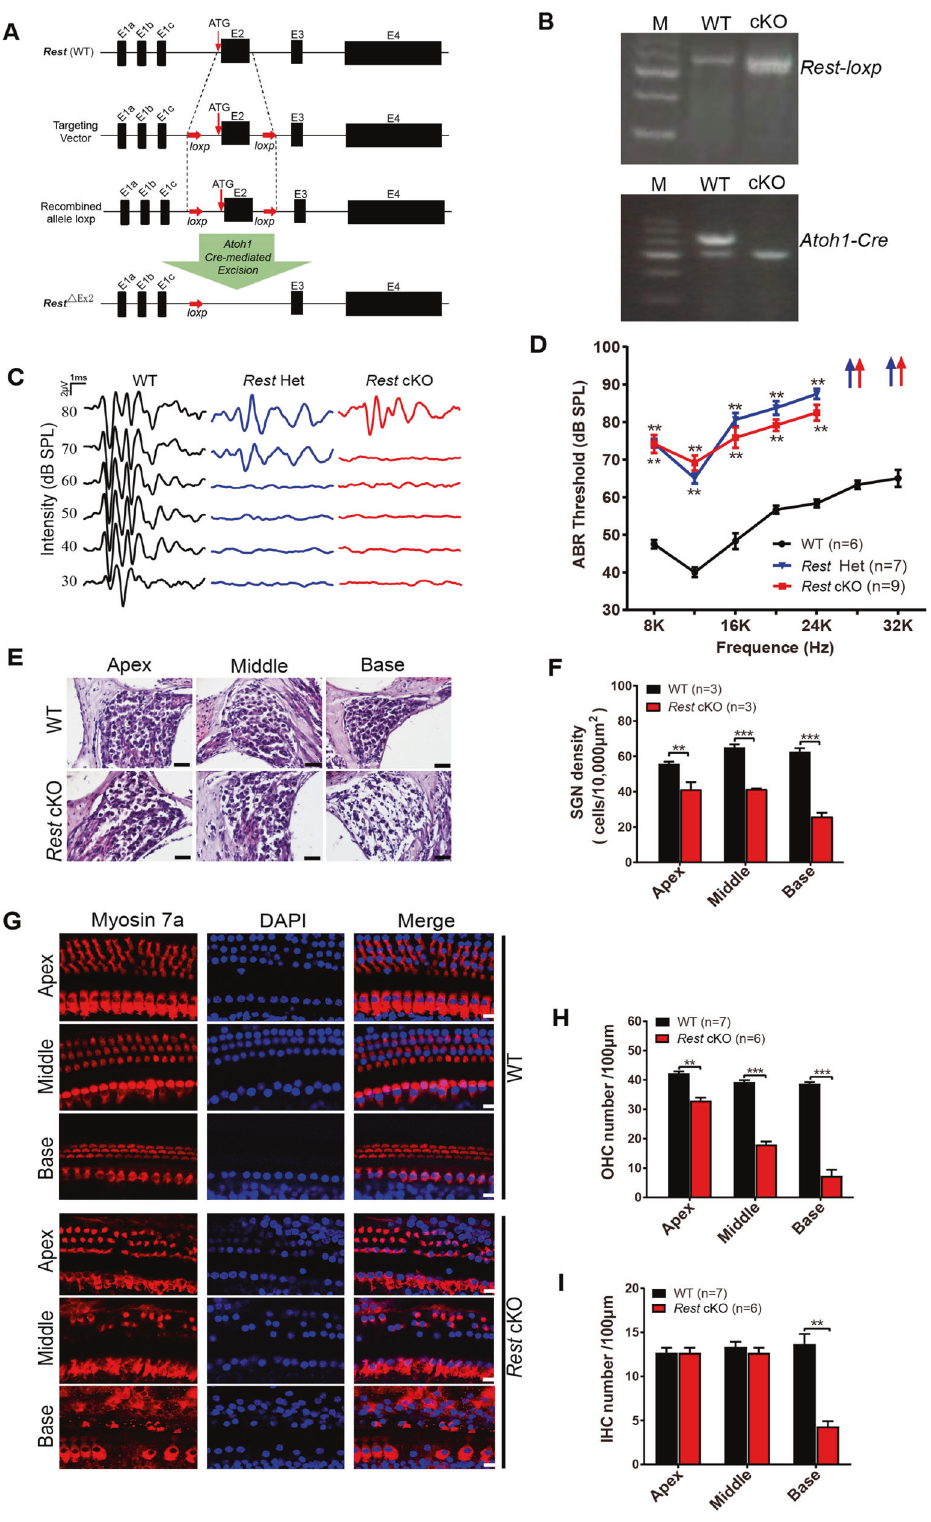
Fig. 3 Deletion of REST in cochlear results in hearing impairment in mice. A Schematic illustration of the Rest conditional knockout ( Rest cKO) generation process. Two LoxP sites are inserted on either side of the coding sequence of exon 2. Expression of Cre recombinase is activated by a speci fi c Atoh1 promoter in the cochlea, resulting in loss of REST function in the cochlea. B Modi fi ed Rest fl ox allele exon 2 and Atoh1 - Cre insertion was con fi rmed by PCR genotyping of DNA extracted from cochlea of vehicle (WT), or Rest cKO mice. C Representative ABR waveforms of WT, Rest Het (Heterozygote mice), and Rest cKO (Homozygous mice). D ABR thresholds of WT, Rest Het, and Rest cKO mice in response to pure tone stimuli (8 – 32 kHz). E Morphological changes of SGNs from WT and Rest cKO mice. Scale bar: 20 µm. F The density of SGNs was quanti fi ed in WT and Rest cKO mice. G Morphological changes in HCs were observed from WT and Rest cKO mice. Scale bar: 10 µm. H , I Quanti fi cation of OHCs and IHCs in WT and Rest cKO mice. Data are represented as mean ± SEM. ** P < 0.01, *** P < 0.001. Cell Death and Disease (2022)